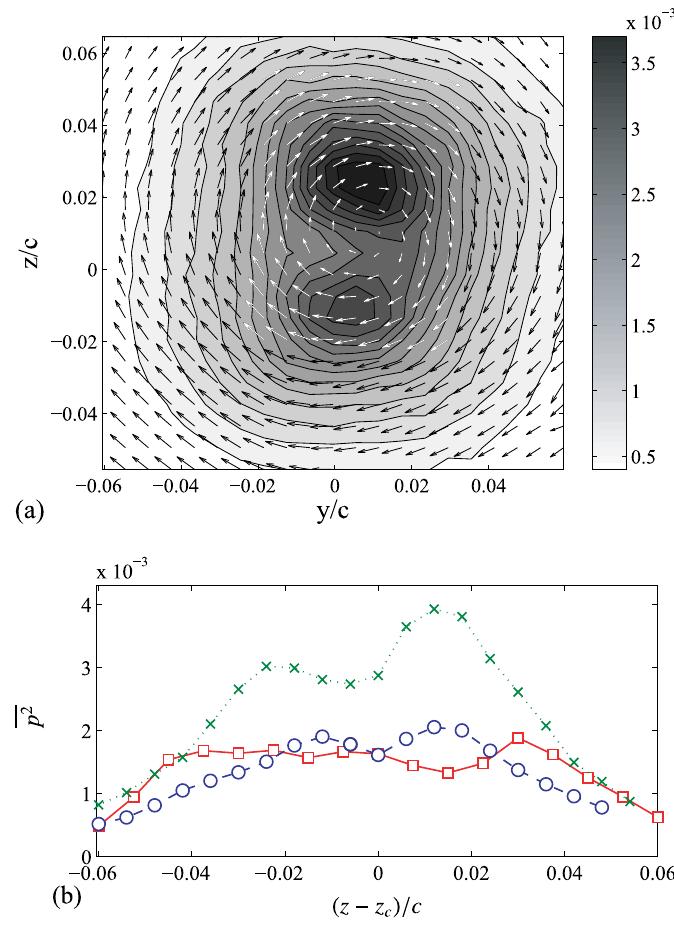
Fig. 7 Distributions of the pressure fluctuation: (a) contour plot at x / c = 1.0; (b) line plots in z direction. (cid:2) , x / c = 0.1; ◦ , x / c = 0.5; × , x / c =